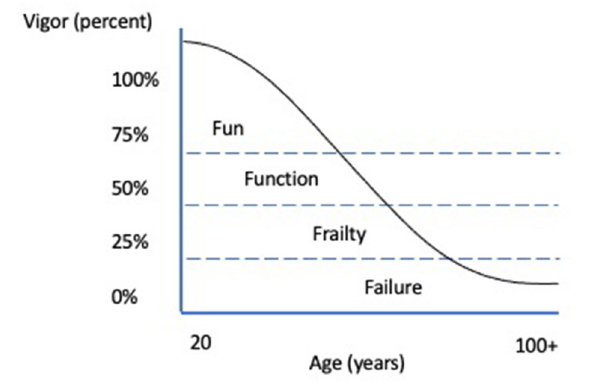
TABLE 2 | Canine task dependent